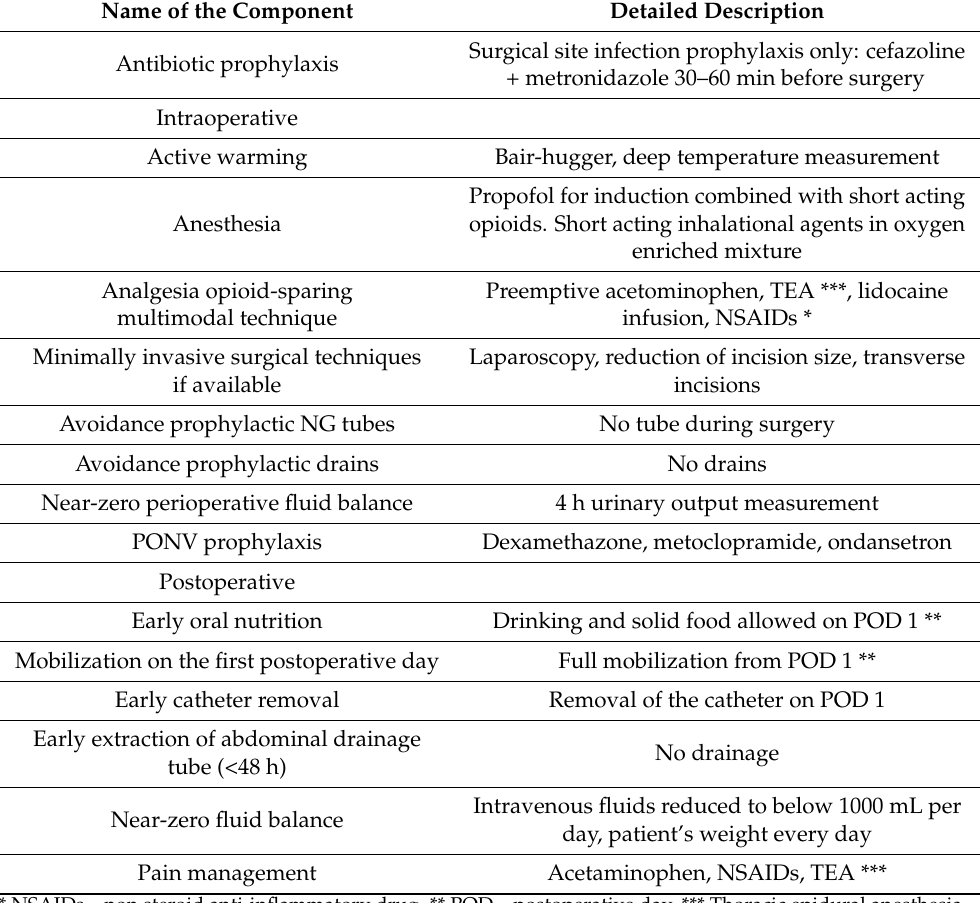
Table 1. Cont. Name of the Component Detailed Description Surgical site infection prophylaxis only: cefazoline Antibiotic prophylaxis + metronidazole 30–60 min before surgery Intraoperative Active warming Bair-hugger, deep temperature measurement Propofol for induction combined with short acting opioids. Short acting inhalational agents in oxygen enriched